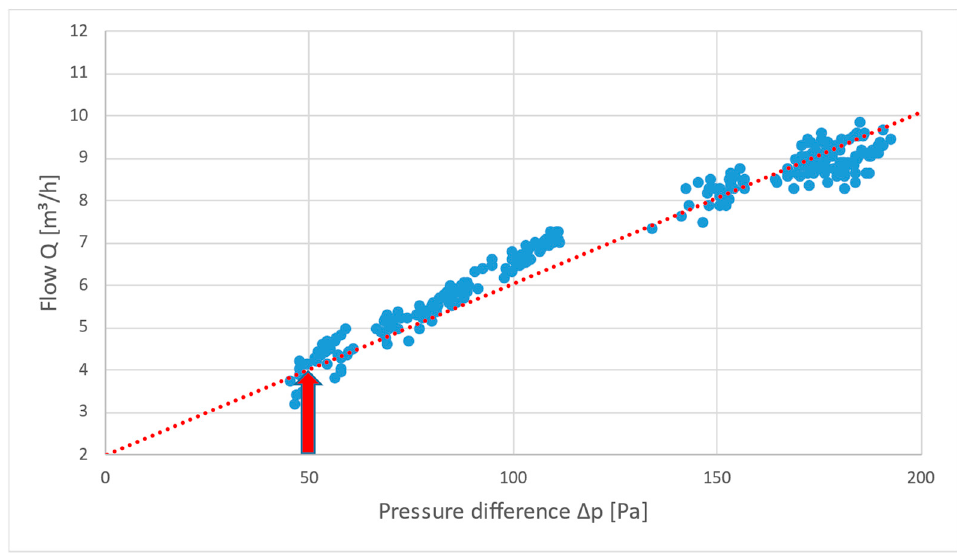
Figure 13. The air permeability at the end of the drying process (dry state), 24 February 2022 (probe V2 15.8%) Q 50 = 4.43 m 3 /h, q 50 = 1.82 m 3 /(m 2 .h).